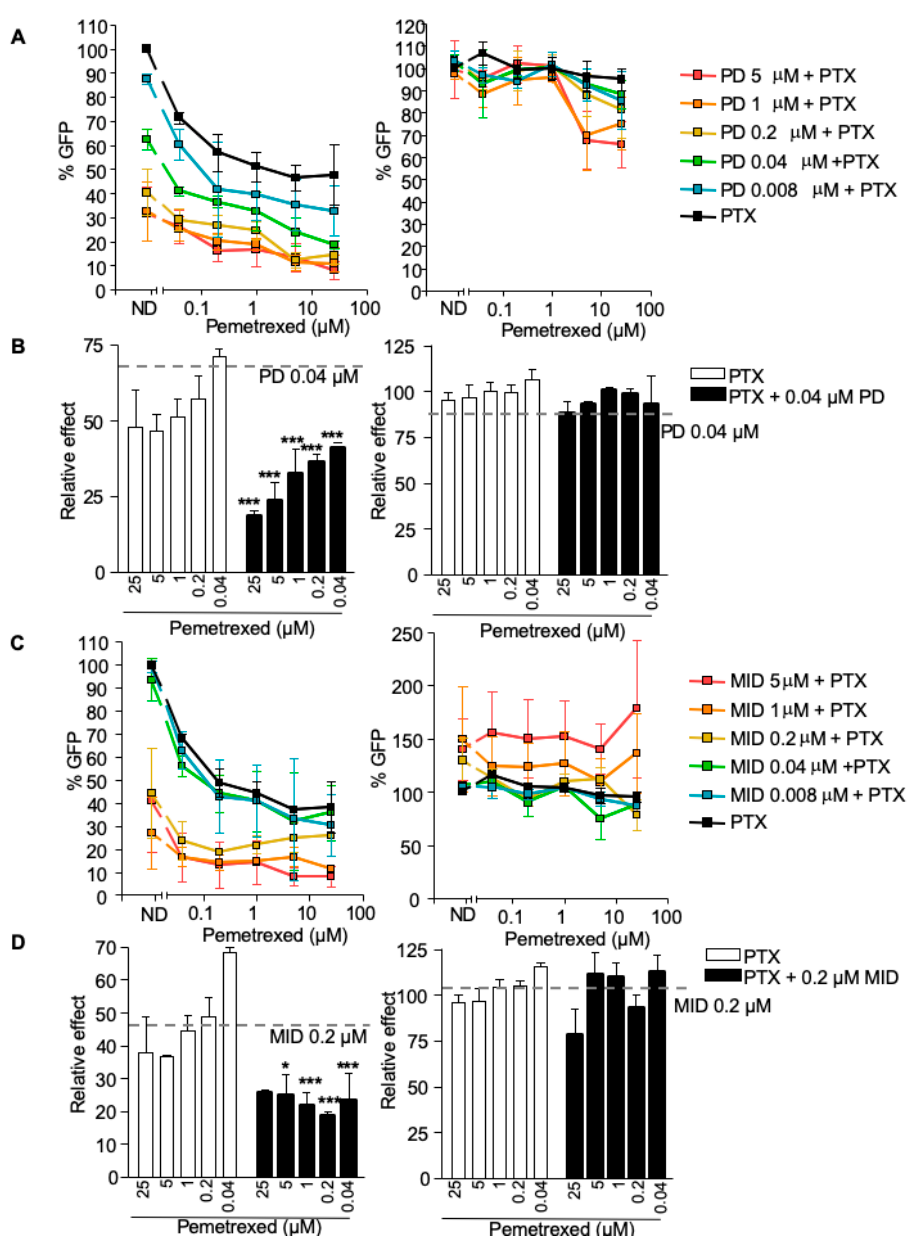
Figure 4. Pharmacological activation of SAMHD1 enhances antiviral activity of antimetabolites. ( A ) Relative e ff ect of the combination of palbociclib-pemetrexed measured as antiviral activity. Inhibition of HIV infection with increasing doses of palbociclib and pemetrexed was measured. Percentage of GFP + cells relative to the no drug condition is shown in presence (left panel) or absence (right panel) of SAMHD1. Mean ± SD of at least three independent donors performed in duplicate is shown. ( B ) As in ( A ), relative e ff ect of pemetrexed alone (white bars) or in combination with a fixed dose of palbociclib 0.04 µ M (black bars), in the presence (left panel) or absence (right panel) of SAMHD1. Mean ± SD of at least three independent donors performed in duplicate is shown. ( C ) Relative e ff ect of the combination of midostaurin-pemetrexed measured as antiviral activity. Inhibition of HIV infection with increasing doses of midostaurin and pemetrexed was measured. Percentage of GFP + cells relative to the no drug condition is shown in presence (left panel) or absence (right panel) of SAMHD1. Mean ± SD of at least three independent donors performed in duplicate is shown. ( D ) As in ( C ), relative e ff ect of pemetrexed (PTX) alone (white bars) or in combination with a fixed dose of midostaurin 0.2 µ M (black bars), in the presence (left panel) or absence (right panel) of SAMHD1. Mean ± SD of at least three independent donors performed in duplicate is shown. PD, palbociclib; PTX, pemetrexed; MID, midostaurin. * p < 0.05; ** p < 0.005; *** p <